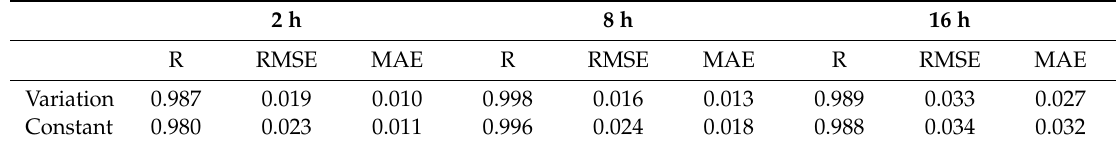
Table 5. Statistical performances of bed variation model in two